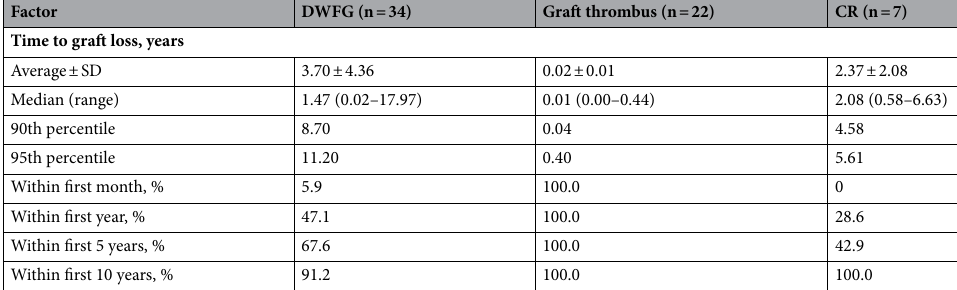
Table 3. Timing of pancreas graft loss after a pancreas transplant based on cause. The time to graft loss was significantly shorter in the graft thrombus group than in the DWFG group and CR group (p = 0.0002 and p < 0.0001, respectively). There was no significant difference between the DWFG group and CR group (p = 0.4394). The differences between groups were assessed by the Mann–Whitney U test. CR chronic rejection, DWFG death with a functioning graft, SD standard deviation.